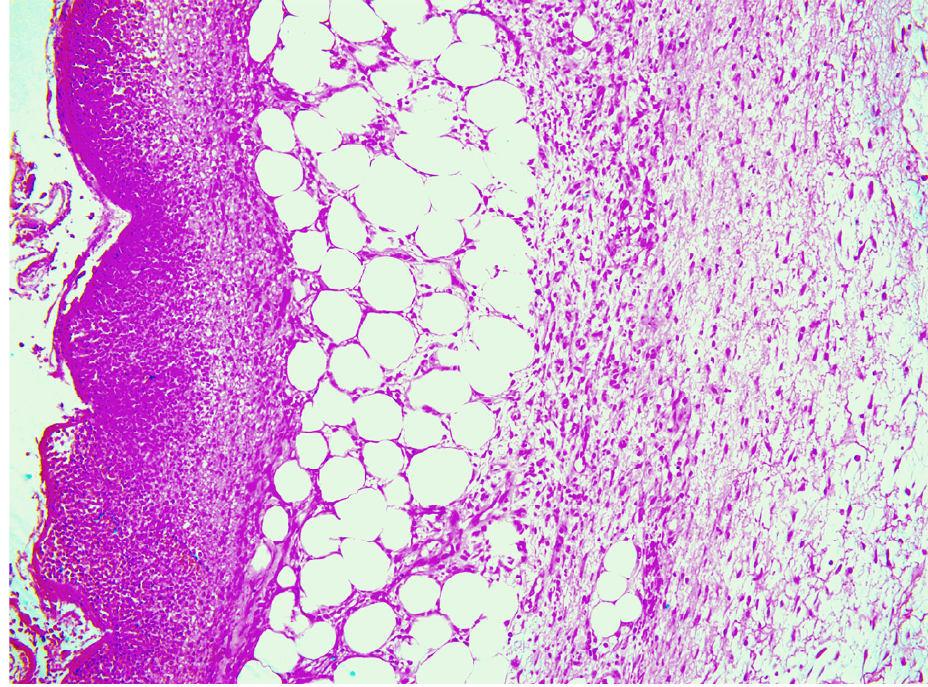
Figure A2. Histology of the wound treated with NO ‐ CGF at post ‐ operative day 4, hematoxylin and eosin staining, magnification—10×.